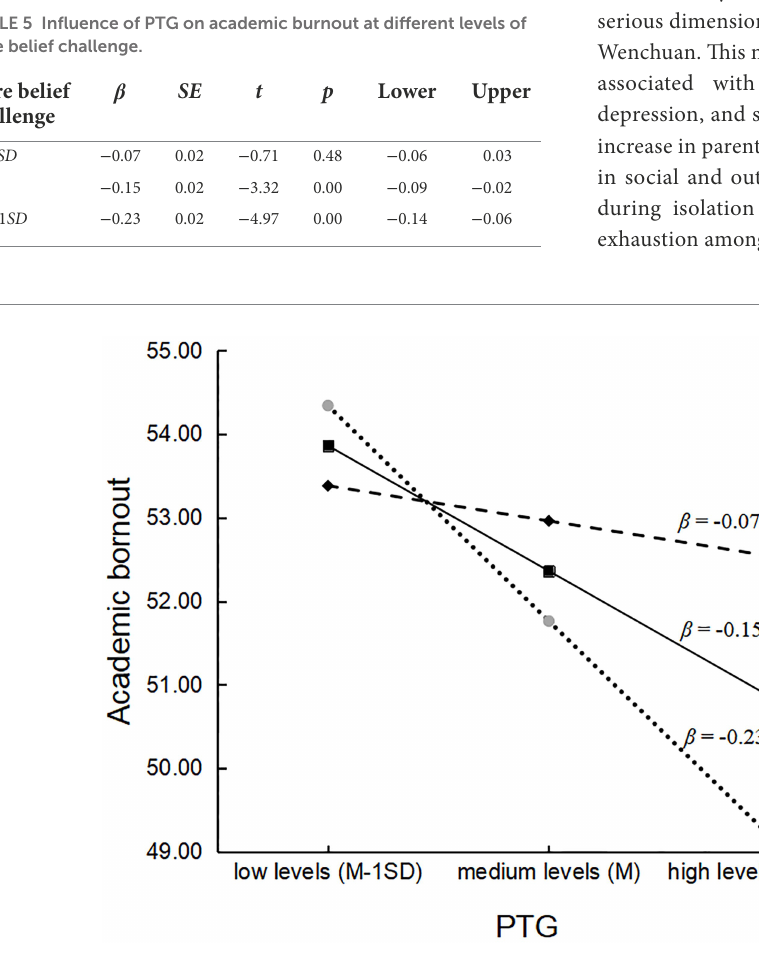
FIGURE 1 Moderating effect of the core belief challenge on the relationship between PTG and academic burnout in